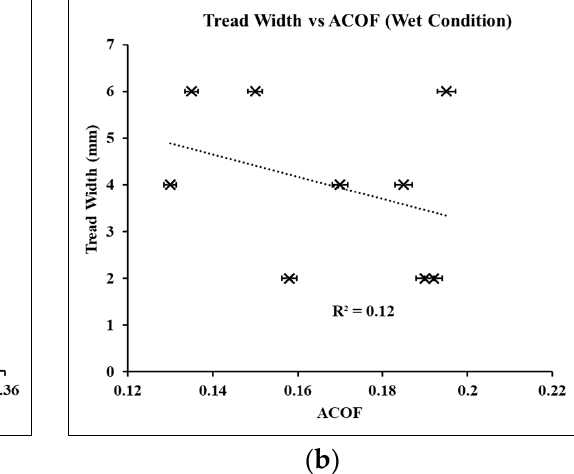
( b ) Figure 9. Effect of tread gap on: ( a ) induced fluid pressure and ( b ) mass flow rate. 3.3.2. Effect of Tread Width on ACOF, Fluid Pressure, and Flow Rate Figure 10 shows the correlations between the altering tread widths (i.e., the width = 2 mm, 4 mm, and 6 mm) and the shoe–floor traction in dry, as well as wet, slipping con- ditions. In dry conditions, increasing the tread width exhibited increased ACOF out- comes. The width and ACOF were observed to be strongly (R 2 = 0.79) and positively cor- related (Figure 10a). Specifically, outsoles O1, O2, and O3, having smaller tread widths, showed lower ACOF compared to the other outsoles. The outsoles O4, O5, and O6, having